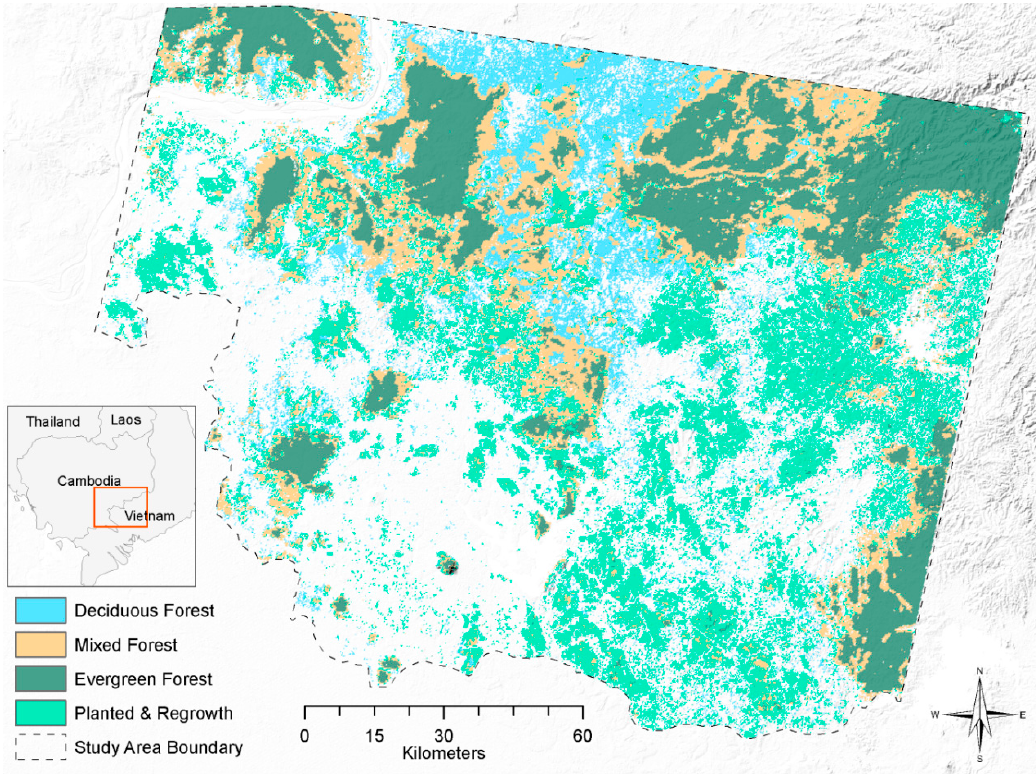
Figure 1. Study area map with forest cover for year 2000. See Section 3.3 for details of forest classification.